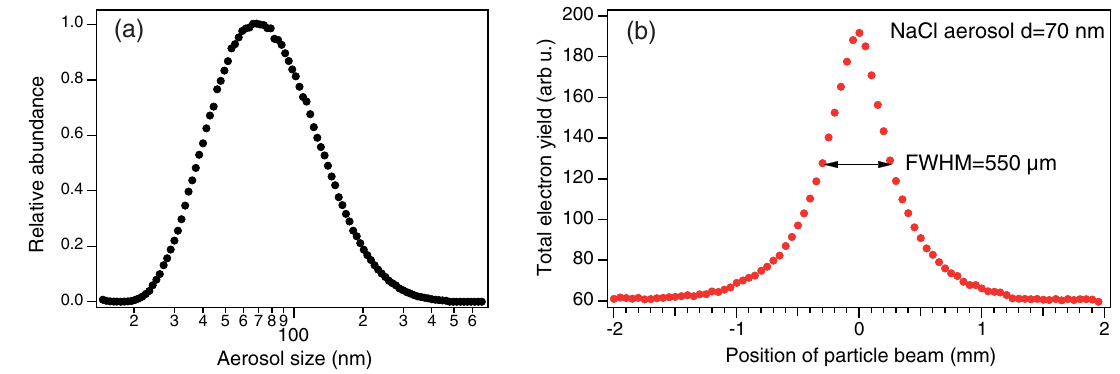
FIG. 1. (a) Aerosol-size distribution after spraying of a 1 g = L 1% NaBr = NaCl solution and subsequent drying. (b) Total electron yield from d ¼ 70 -nm aerosol ionized with a photon energy of 100 eV while moving the outlet of the aerodynamic lens system. The aerosol beam is found to have a full-width-at-half maximum of 550 μ